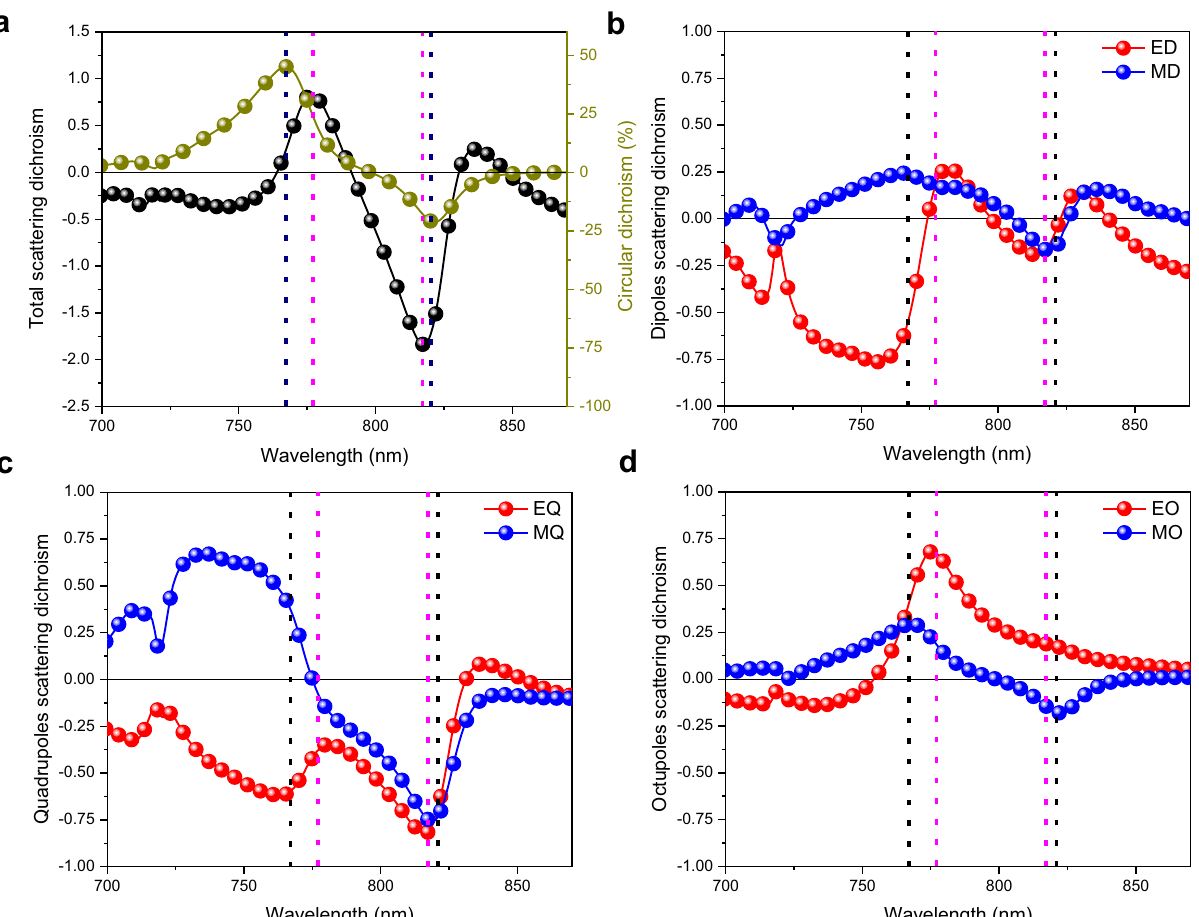
Fig. 4 Scattering cross section dichroism of the electromagnetic multipoles in perovskite chiral metasurfaces. a Closely matching response of total scattering dichroism, CD C (black curve), and circular dichroism, CD (yellow curve), as functions of the wavelength. b – d Contribution of individual S multipoles to the strong dichroism of the perovskite chiral metasurface: b electric (red curve) and magnetic (blue curve) dipole scattering dichroisms, CD C and, CD C , as function of the wavelength; c electric (red curve) and magnetic (blue curve) quadrupole scattering dichroisms, CD C ED MD function of the wavelength; d electric (red curve) and magnetic (blue curve) octupole scattering dichroisms, CD C wavelength. The vertical black dotted lines indicate the peaks of the CD spectrum, while the pink dotted lines correspond to the peaks of the CD C the electromagnetic fi eld at the bottom surface of the superstructure. For the angle- dependent CD, the Bloch boundary conditions are applied to the directions normal to the light propagation direction. Circular dichroism spectra . The circular dichroism spectra were obtained by measuring the optical transmission of right- and left-handed chiral metasurfaces, under right- and left-handed circularly polarized illumination, in a Nikon inverted optical microscope, equipped with a halogen lamp (as shown in Fig. 2b). The polarizations of the incident light were prepared by sending the light through a polarizer and a broadband λ /4 waveplate (Thorlabs AQWP05M-580) with nearly achromatic transmission, 0.95 < T <0.98, and retardance, 0.24 < ρ < 0.26, in the spectral region investigated. The light was focused on the sample using a Nikon